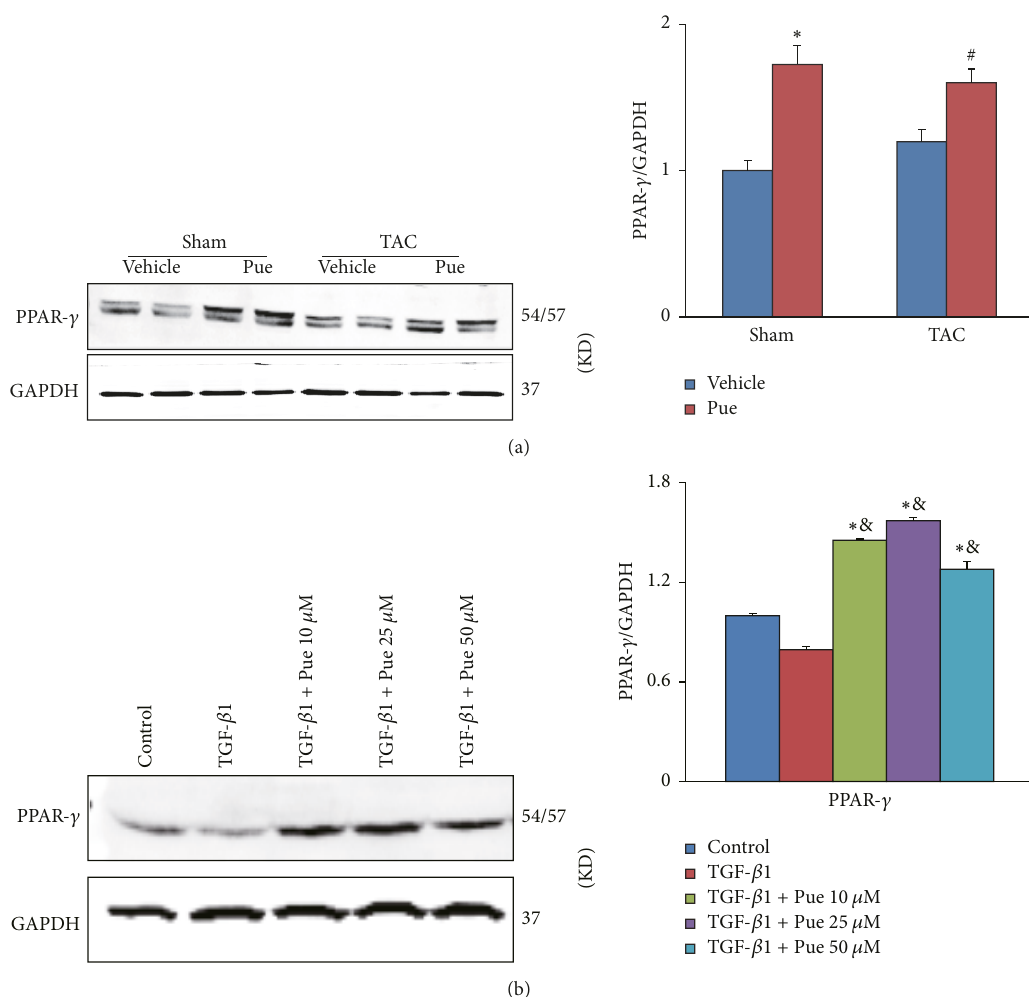
Figure 6: PPAR- 𝛾 protein expression was upregulated by puerarin . (a) PPAR- 𝛾 protein levels in mice hearts in indicated groups were detected by WB, normalized to GAPDH (𝑛 = 6) . ∗ 𝑝 < 0.05 versus sham + vehicle group; # 𝑝 < 0.05 versus TAC + vehicle group. (b) HUVECs were preincubated with different concentrations of puerarin (10, 25, 50 𝜇 M) for 30 min and then treated with TGF- 𝛽 1 (10ng/ml) for 48 h. PPAR- 𝛾 protein levels in cell lysates in indicated groups were detected by WB, normalized to GAPDH (𝑛 = 6) . ∗ 𝑝 < 0.05 versus control group; & 𝑝 < 0.05 versus TGF- 𝛽 1